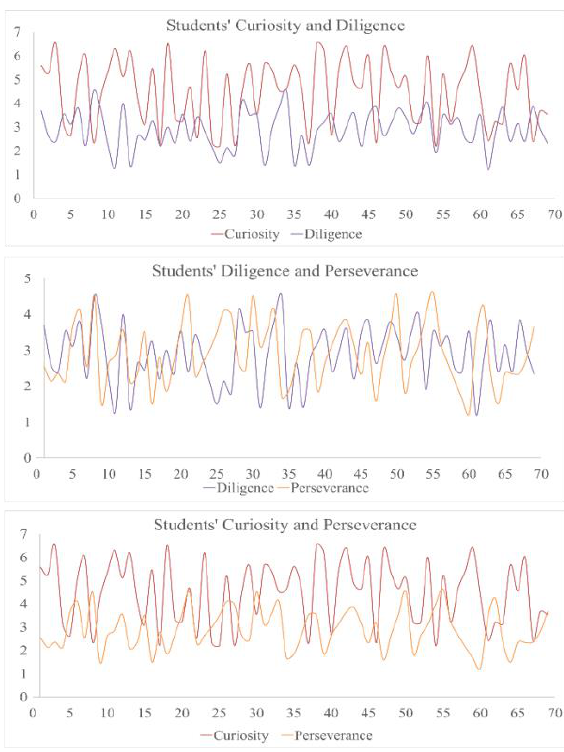
Fig. 3: Student perception of their curiosity, diligence and perseverance